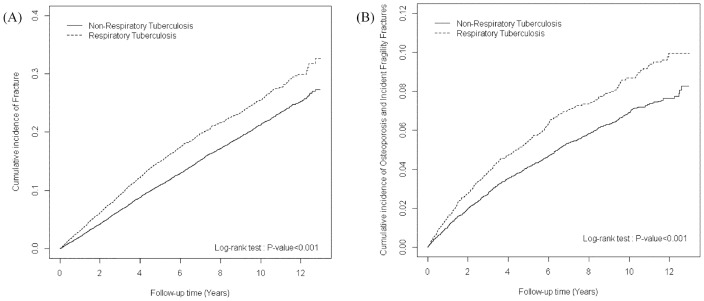
The cumulative incidence of incident bone fracture (A) and osteoporosis / fragility fracture (B) between non-respiratory tuberculosis cohort (solid line) and respiratory tuberculosis cohort (dashed line).